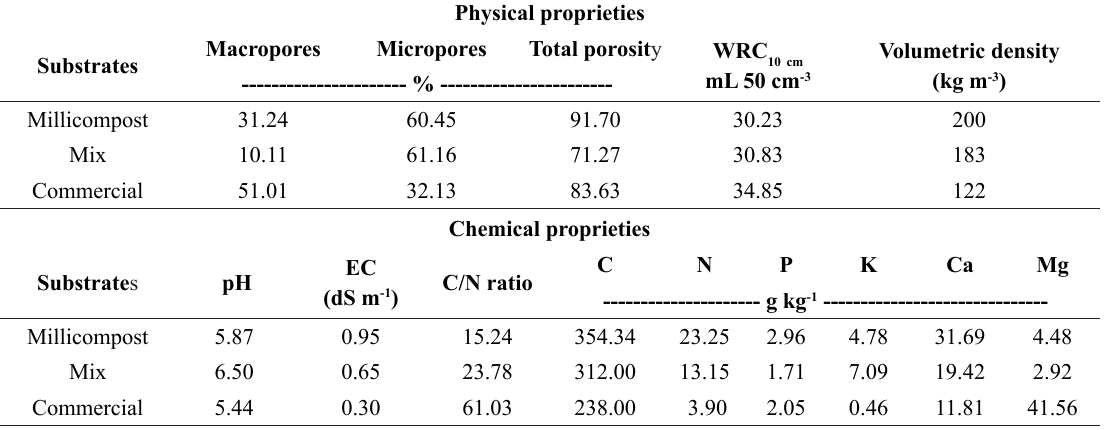
Table 3 Characteristics of the organic substrates used in the production of pepper